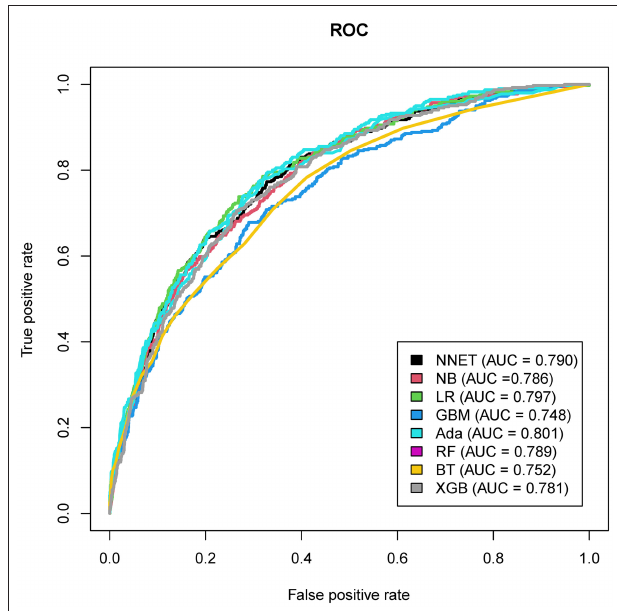
FIGURE 4 | Area under the curve of receiver operating characteristic curve by machine learning models in the validation cohort. ROC, receiver operate characteristics; NNET, artificial neural network; NB, naïve bayes; GBM, gradient boosting machine; Ada, adapting boosting; RF, random forest; BT, bagged trees; XGB, eXtreme Gradient Boosting; LR, logistic regression.